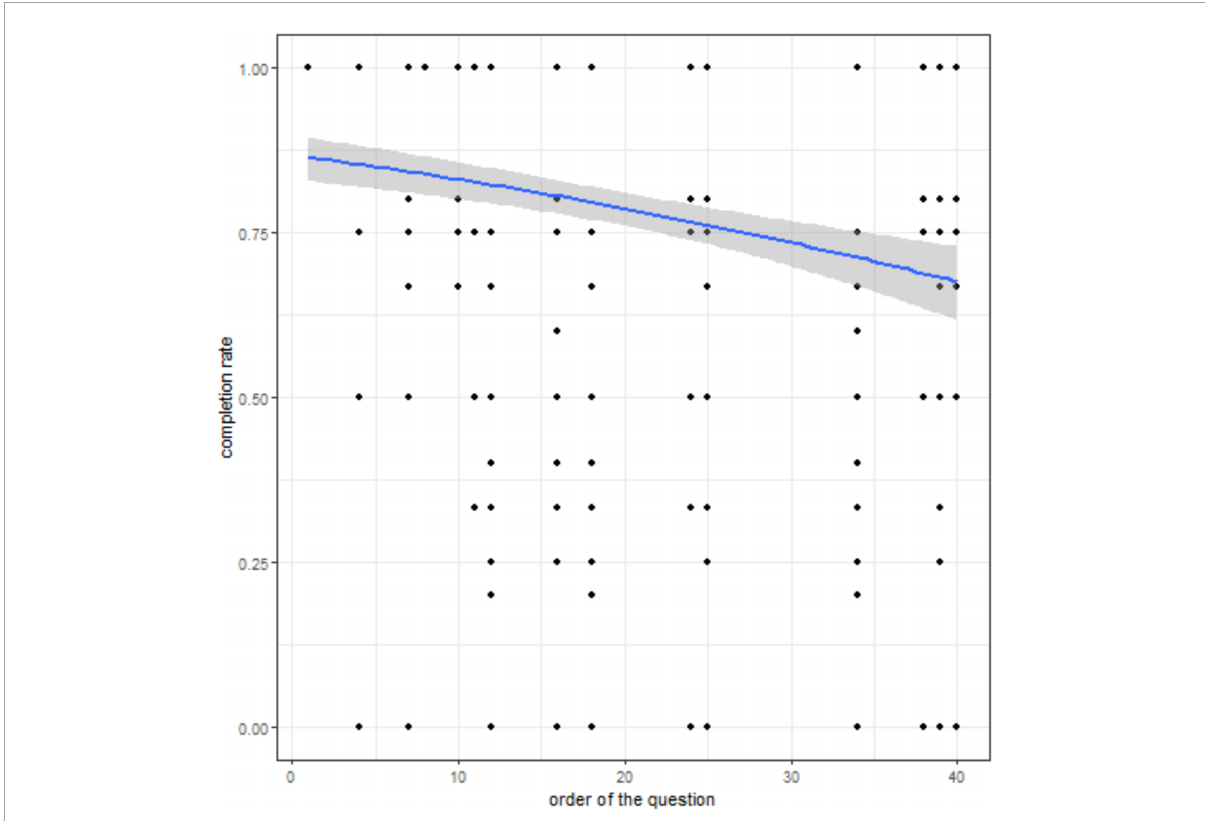
FIGURE5 Completion rate according to the question position in the weekly EMA. Relationship between the question ranking in the weekly EMAs and the completion rate. The predicted probability (blue curve) from the logistic mixed model and its 95% CI (shaded area) are shown. Black dots indicate the completion rate for each patient ( n = 62) and each question asked but not necessarily